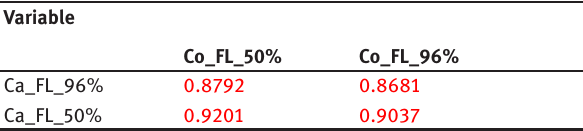
Table 4: The comparison of flower extracts from both tested hawthorn species: C. almaatensis and C. oxyacantha expressed in correlation values.